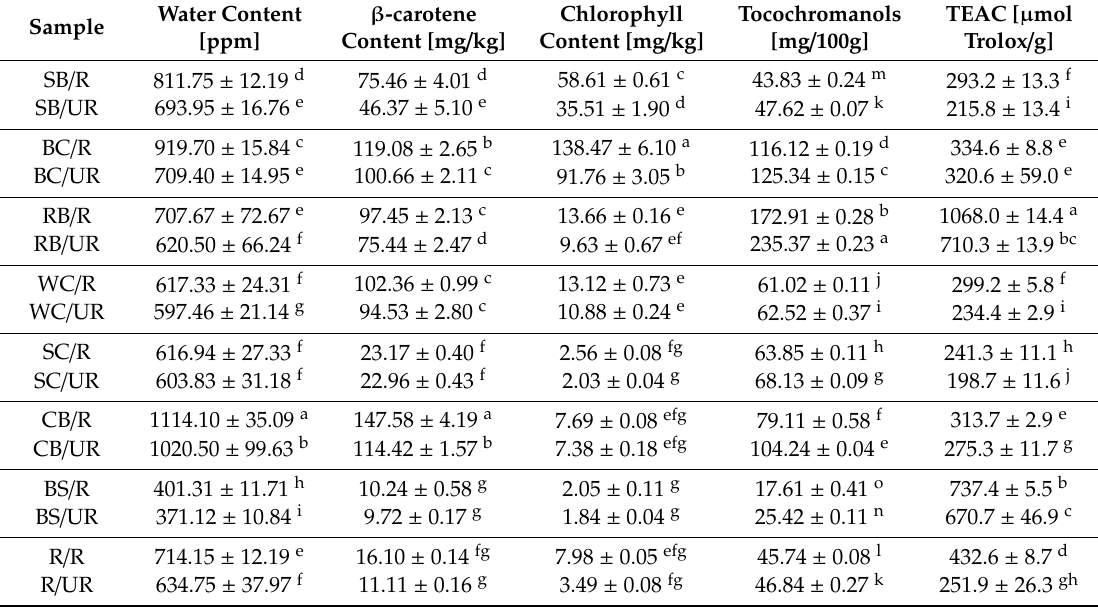
Table 2. Water, β -carotene, chlorophyll, and tocochromanols contents, as well as antioxidant activity of